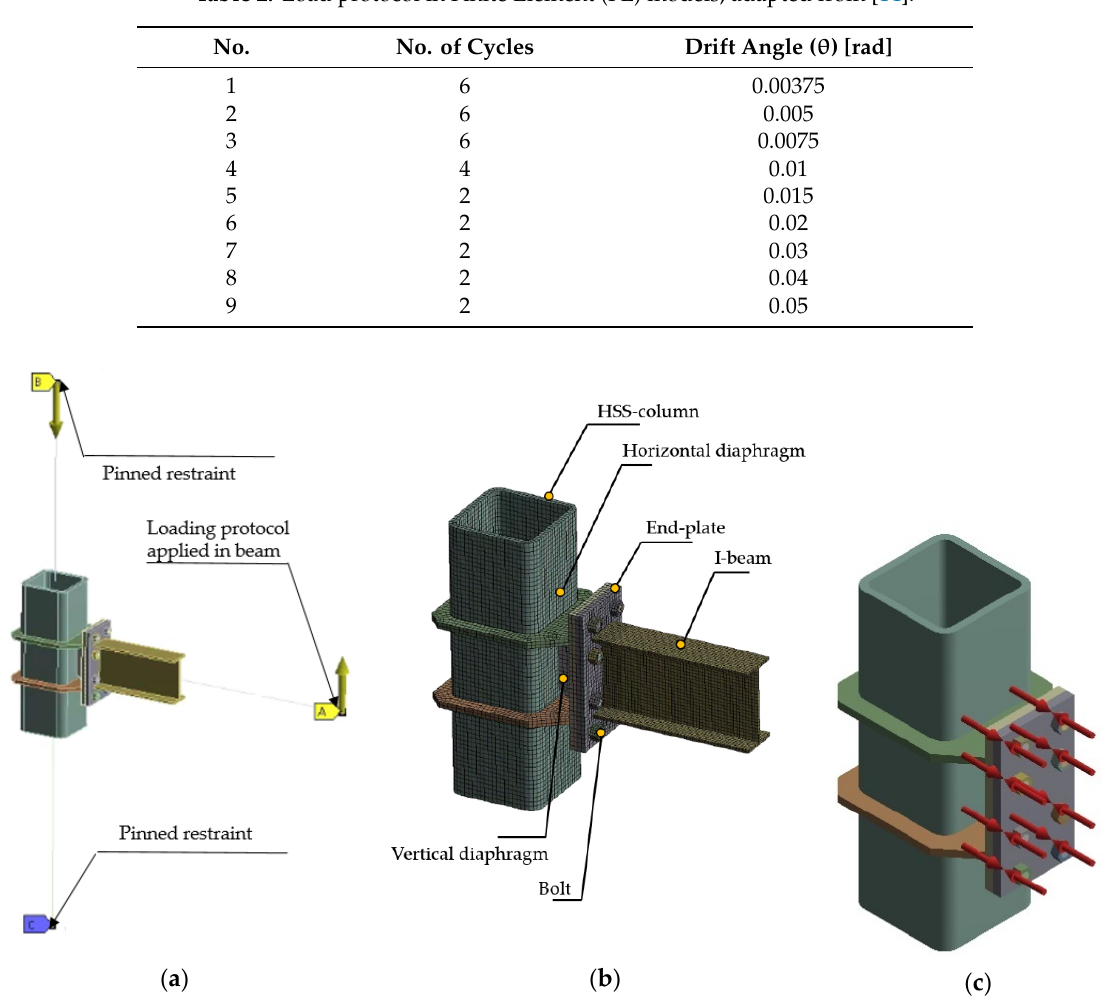
Table 2. Load protocol in Finite Element (FE) models, adapted from [14].